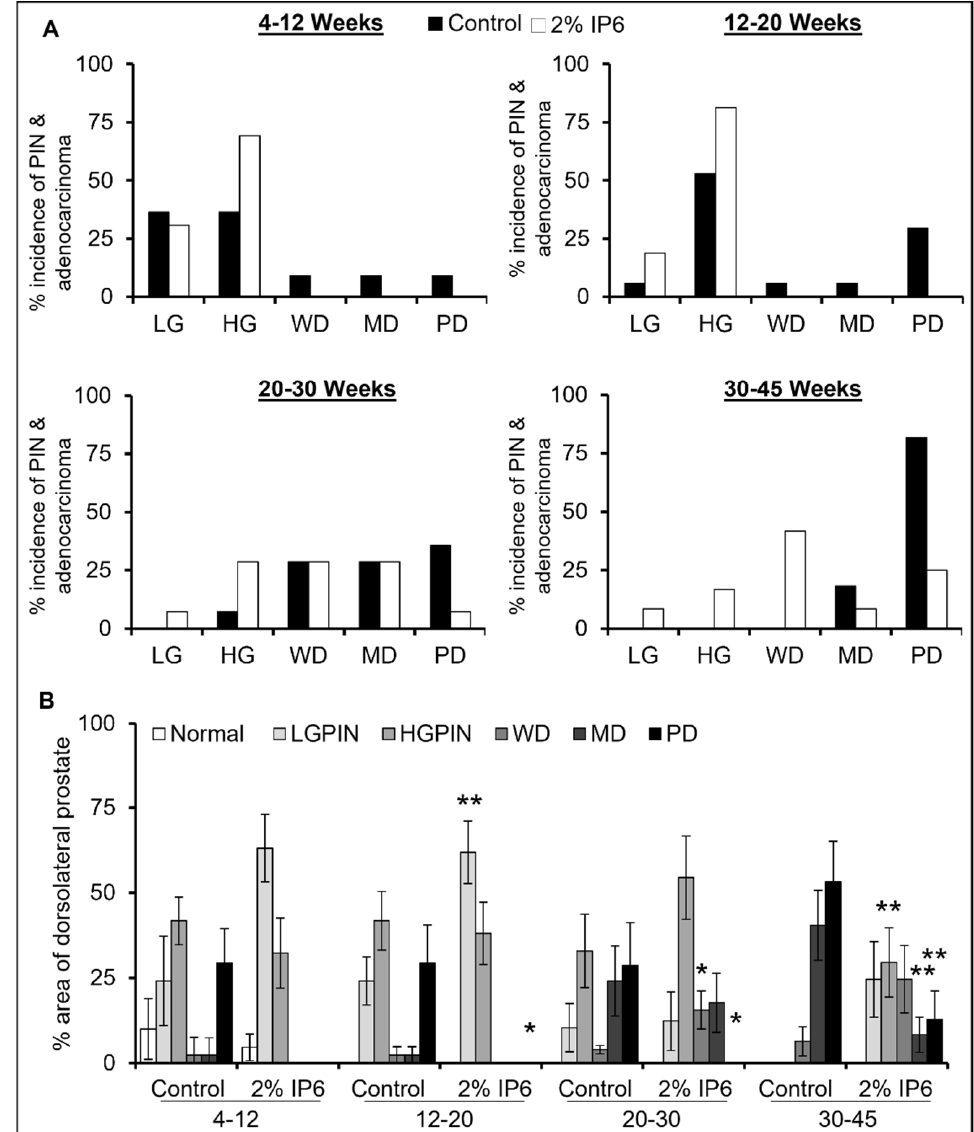
Figure 2. Stage-specific effect of IP6 feeding on pathological changes in dorsolateral prostate of TRAMP mice. ( A ) % incidence of normal, pre-neoplastic, and adenocarcinoma lesions in dorsolateral prostate tissues of TRAMP control and IP6-fed mice. ( B ) % area of dorsolateral prostate lobe displaying normal, pre-neoplastic, and adenocarcinoma lesions in TRAMP control and IP6-fed mice. LGPIN, low-grade prostatic intraepithelial neoplasia; HGPIN, high-grade prostatic intraepithelial neoplasia; WD, well-differentiated (adenocarcinoma); MD, moderately differentiated (adenocarcinoma); PD, poorly differentiated (adenocarcinoma). Quantified data are represented as columns (mean for each group); bars represent SEM. ** p ≤ 0.01, and * p ≤ 0.05 .